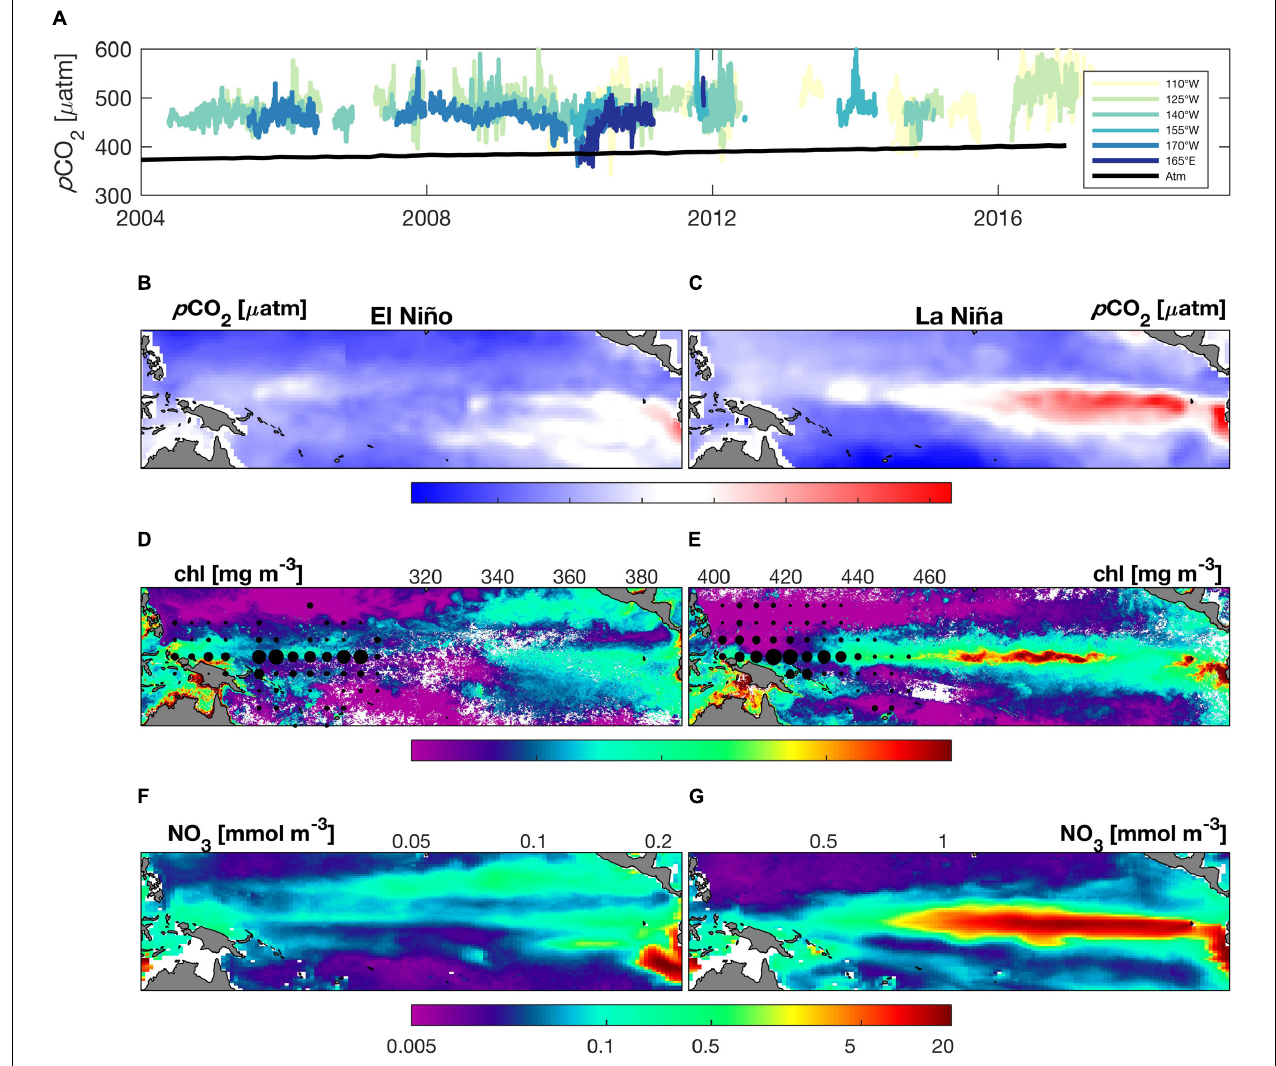
FIGURE 4 | Summary of long term trends and example El Niño (January 1998) vs La Niña (July 1998) conditions for important biogeochemical parameters. (A) Long term trends in surface ocean and atmospheric p CO 2 . The colored lines indicate surface ocean p CO 2 from tropical Pacific moorings, all at 0 ◦ (Sutton et al., 2018). The black line is atmospheric p CO 2 (in ppm) from a station on Easter Island (Dlugokencky et al., 2018). (B,C) Gridded surface ocean p CO 2 from Landschützer et al. (2017). (D,E) SeaWiFS satellite monthly mean surface chlorophyll concentration. The filled circles represent the magnitude of the skipjack tuna catch for El Niño ( D , January–June 1992) and La Niña ( E , January–June 1989), adapted from Lehodey et al. (1997). (F,G) Surface nitrate concentrations from the NASA Ocean Biogeochemical Model (NOBM; Gregg and Casey, 2007; https://giovanni.gsfc.nasa.gov/giovanni/). The latitude/longitude domain in (B) through (G) is 20 ◦ N to 20 ◦ S, 120 ◦ E to 80 ◦